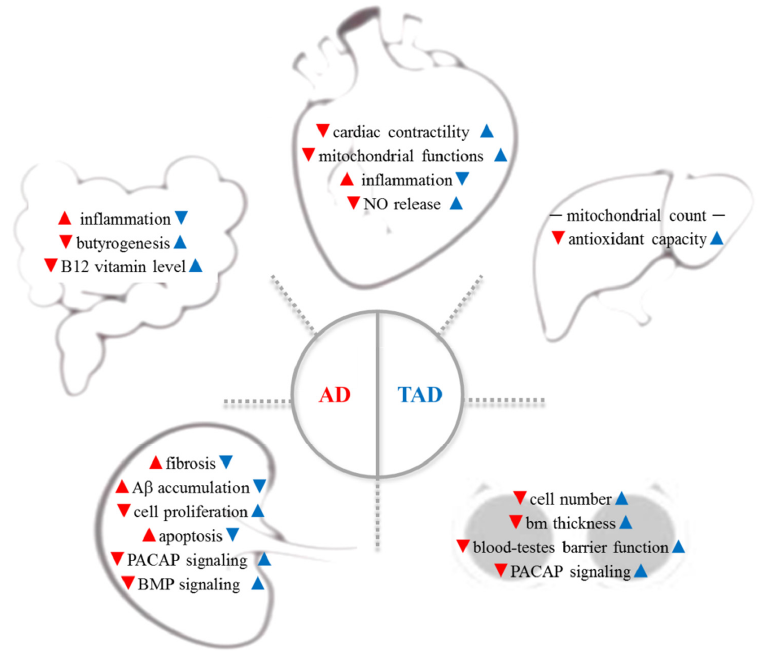
Figure 1. AD is a complex systemic disorder, which induces the degenerative process in organs distant from the brain: cardiovascular system, gut microbiome, liver, testes, and kidney are involved